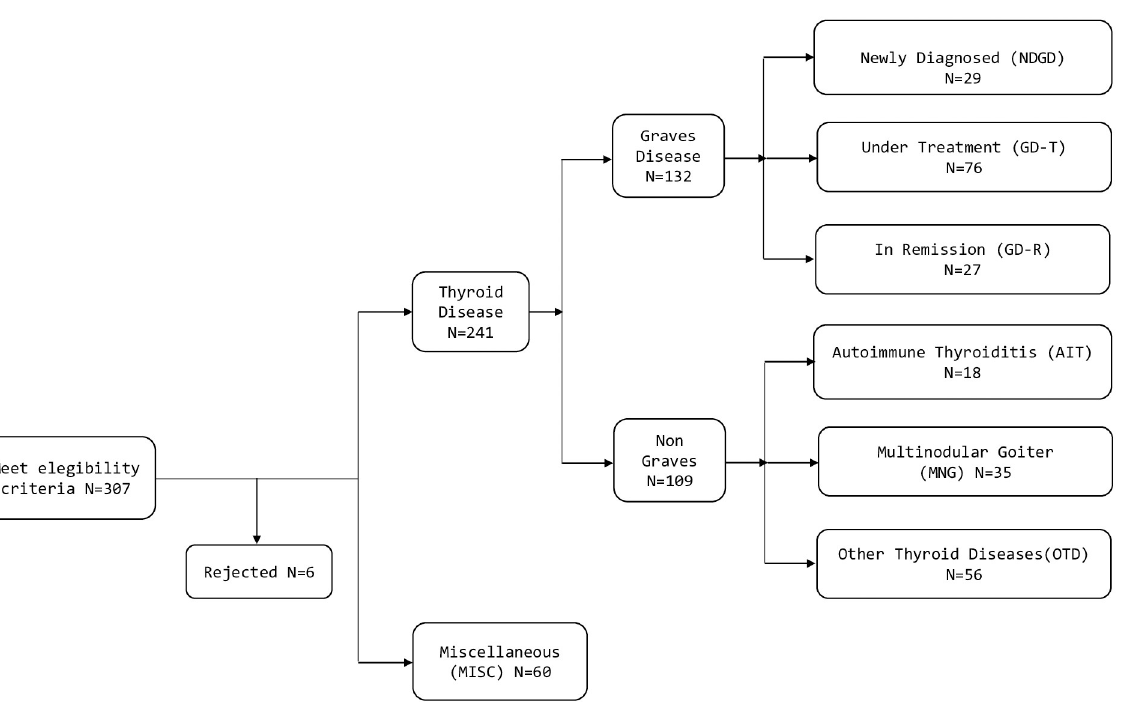
Patients Baseline demographics and clinical characteristics of patients are given in Table 1. Participants were divided in different clinical groups according to their diagnosis (Table 1 and Fig 1): Group 1: 29 newly diagnosed untreated GD patients (NDGD) Group 2: composed by 27 cases of GD patients in remission (GD-R) Group 3: composed by 76 cases of GD patients under treatment, GD-T Group 4: 18 cases of Autoimmune Thyroiditis (AIT), composed by 11 classical Hashimoto’s thyroiditis and 7 postpartum thyroiditis, as assessed by TPO positive antibodies, imaging and hormones levels.